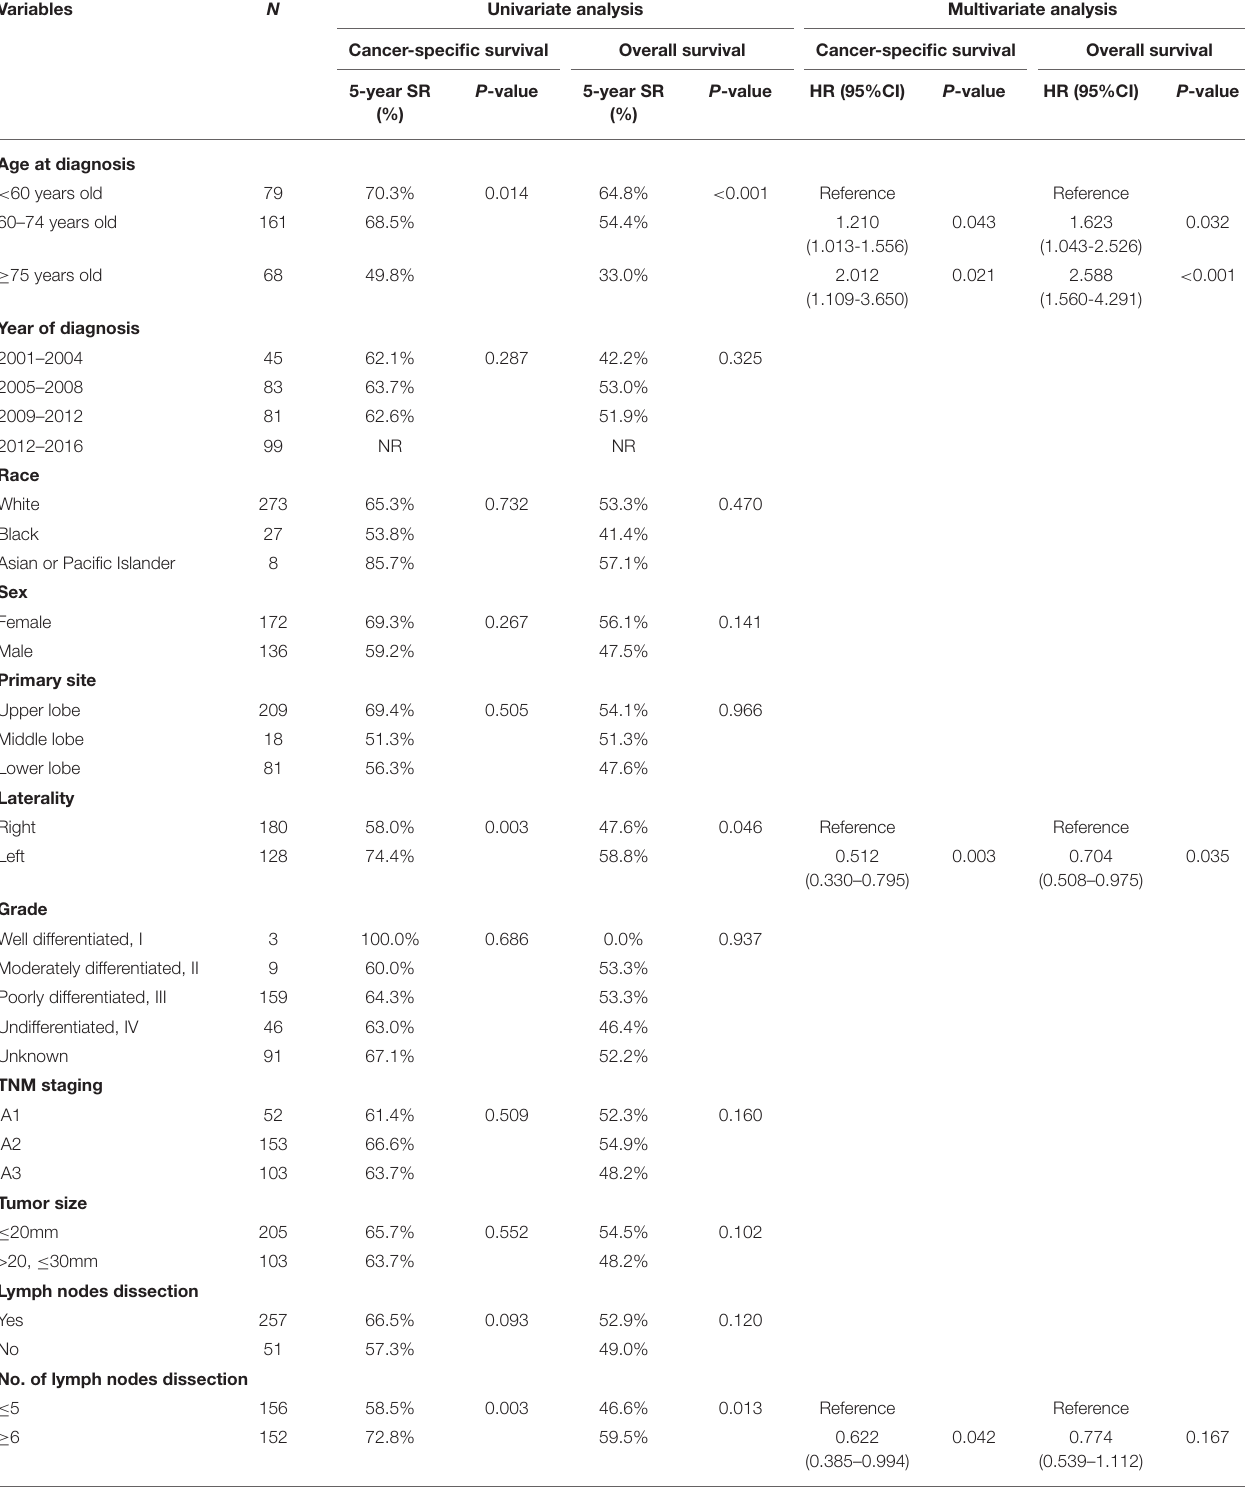
TABLE 2 | Univariate and multivariate analysis of cancer-specific survival and overall survival before propensity score matching.